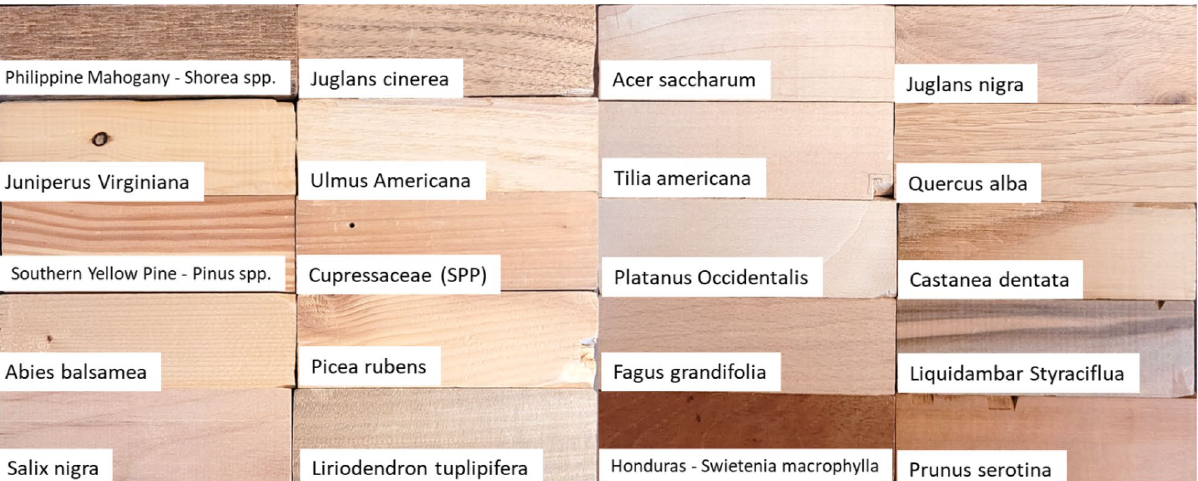
Figure 1. Example of some of the wood samples used in this study (all housed in the Garman Art Conservation Department, SUNY – Buffalo